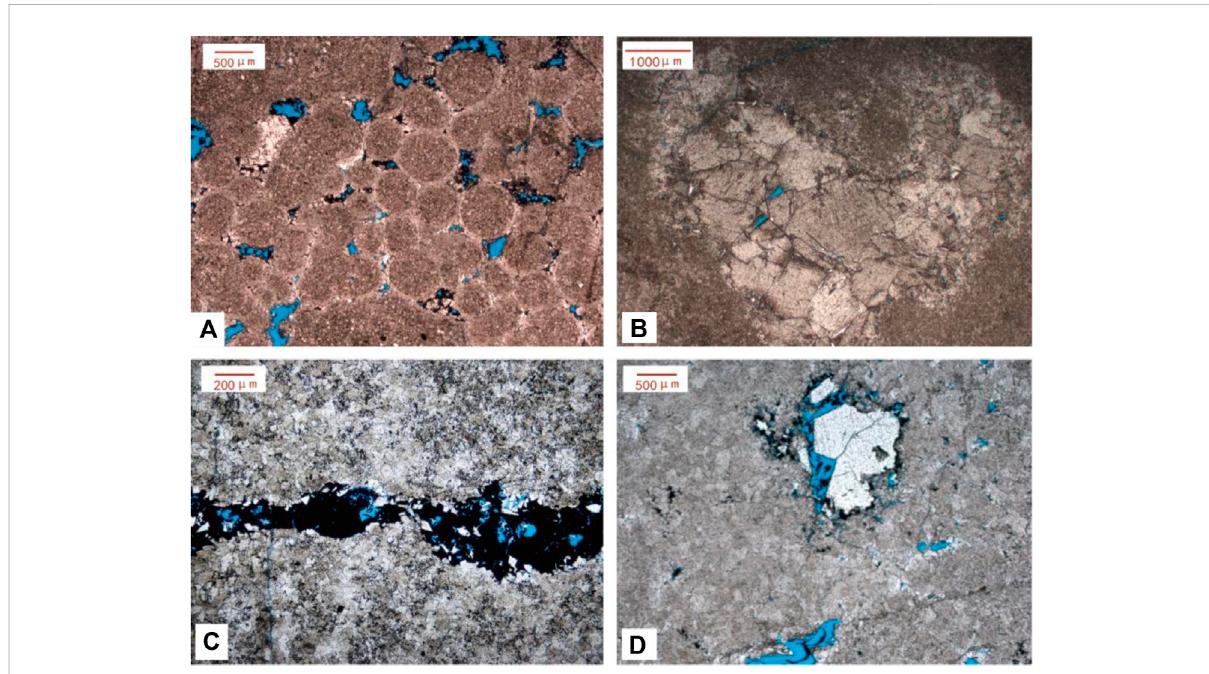
FIGURE 9 Diagenesis types andcharacteristics oftheLongwangmiaoFormation inthestudyarea. (A) The fi rst-stageannulardolomitecement developed aroundthegrains,WellGS6,4545.49 m,singlepolarizedlight; (B) Pores fi lledwithmediumandcoarse-grainedcementsfromthesecondstage,Well GS23, 4691.65 m, single polarized light; (C) Structural dissolving fracture nearly completely fi lled with dolomite and asphalt, Well MX16, 4755.47 m, single polarized light; (D) Pore fi lled with hydrothermal quartz, well GS001-X24, 4580.27 m, single polarized